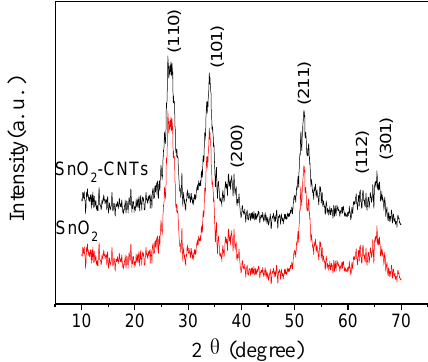
Figure 1. X-ray diffraction (XRD) patterns of SnO 2 -CNTs (carbon nanotubes) nanocomposite and SnO 2 .